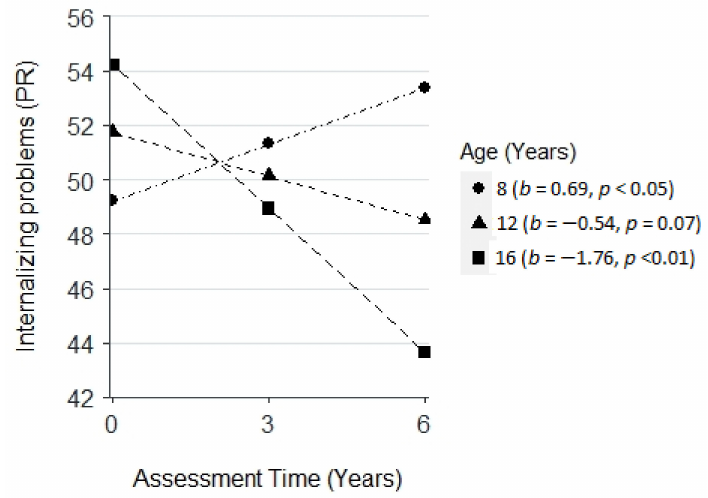
Figure 1. Plot for the interaction effect among assessment time and age at baseline on internalizing problems (parent-reported, PR). Three levels of baseline age were plotted: 8 years (1 SD below the mean), 12 years (the mean), and 16 years (1 SD above the mean).